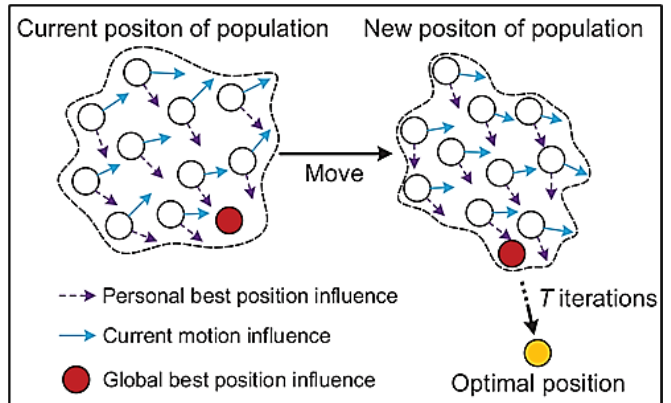
Figure 2. Schematic of a basic PSO and the move.